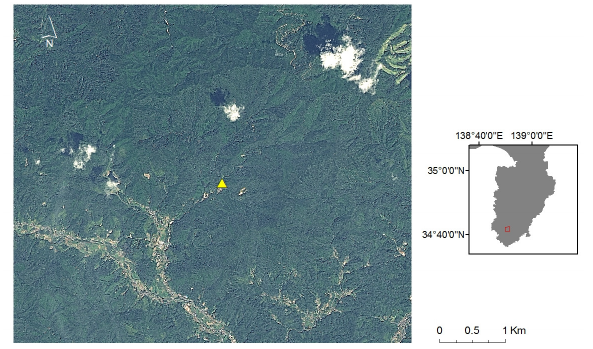
Figure 1. Refraction of light between air and water However, TLS is not built specifically for through-water scanning and collected data takes no account of this refraction.